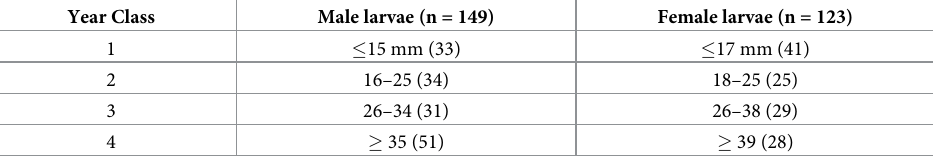
Table 1. Year class lengths and frequency distribution of Pteronarcys californica larvae collected 30 April- 1 May 2010 from the Colorado and Fraser Rivers. Lengths in mm from anterior tip if head to posterior tip of